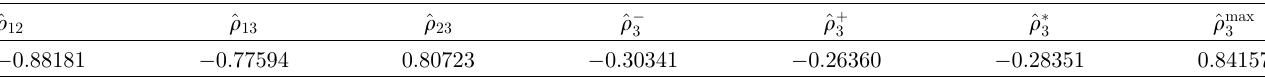
Table 2. Estimators of the coef fi cients. (i) percentage of population less than 15 years old (code 1), (ii) percentage of the population over 75 years old (code 2) and (iii) per-capita disposable income (code